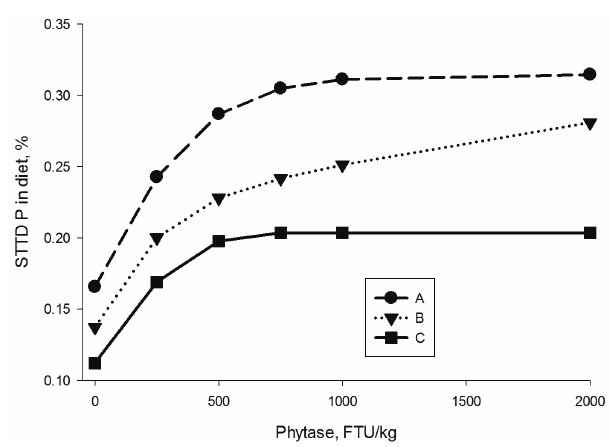
Figure 7. Effect of phytase dose on standardized total tract digestible (STTD) P content in three hypothetical diets fed to 25-kg pigs. Refer to Table 6 for the ingredient and nutrient composition of these hypothetical diets. FTU, phytase